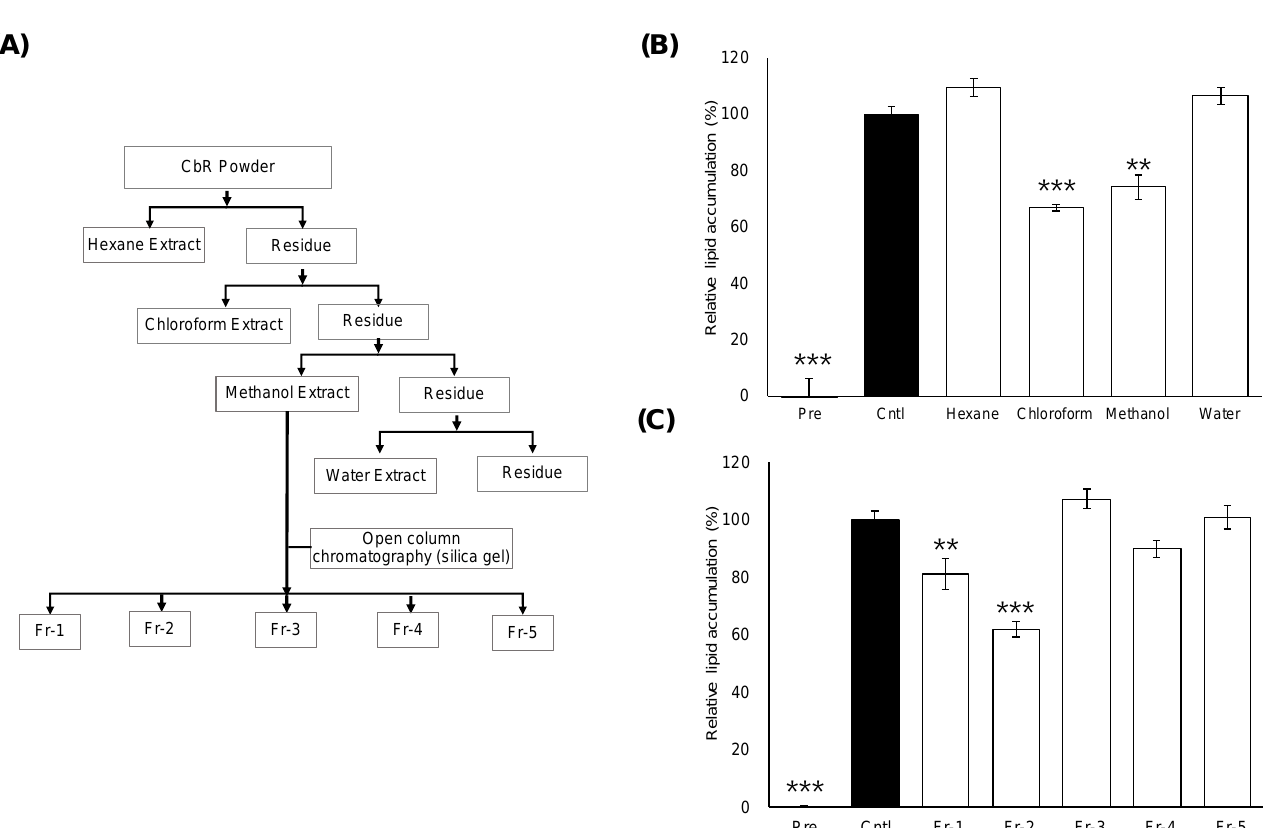
Figure 1. Effects of extracts and fractions from Cirsium brevicaule A GRAY root (CbR) on 3T3-L1 cells. ( A ) Flowchart for the isolation of active anti-obesity compounds from Cirsium brevicaule A GRAY root (CbR). ( B ) Inhibitory effects of the CbR extract on cellular lipid accumulation. ( C ) Inhibitory effects of the fractions derived from the methanol extract on cellular lipid accumulation. 3T3-L1 cells were treated with 500 µ g/mL of crude extracts or 100 µ g/mL of individual fractions of the crude extracts with 0.5% DMSO as the vehicle. The results are presented as means ± SEM of three independent experiments ( n = 3). The asterisk (*) indicates a significant difference between control and treatment groups by Dunnett’s test. ** p < 0.01, and *** p < 0.001 vs. control (Cntl) and preadipocytes (pre).